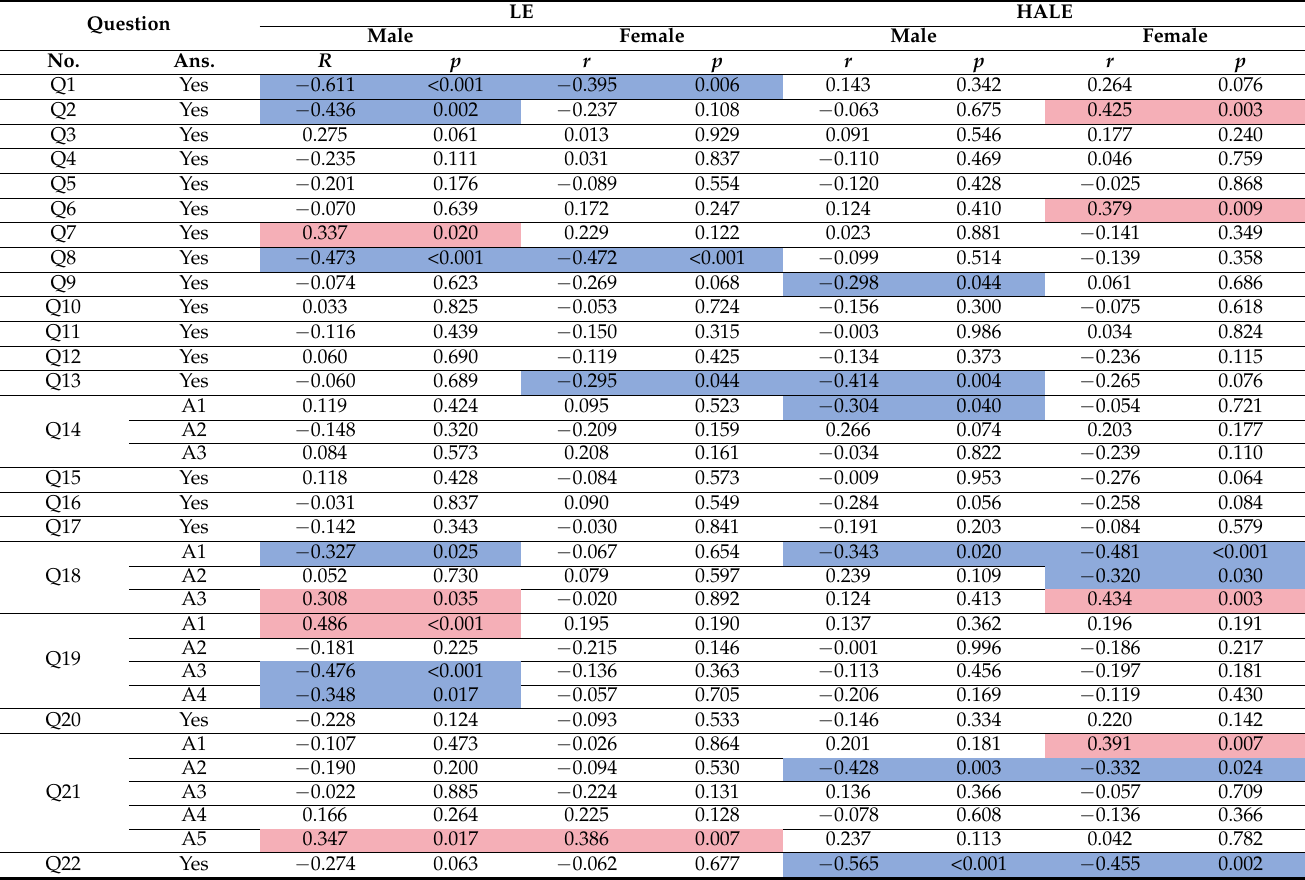
Table 6. Correlation coefficient between health checkup variables (questions on health habits) and summary population health outcomes (LE and